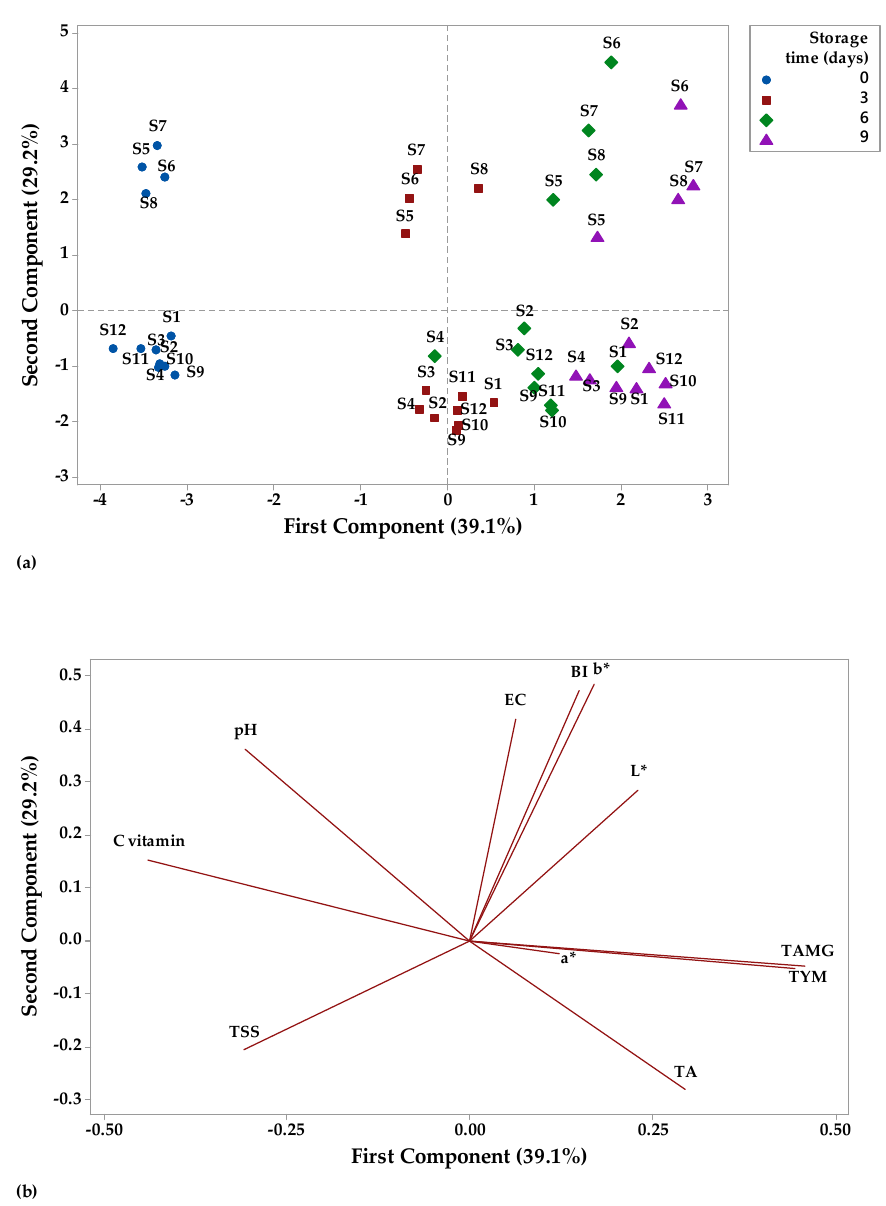
Figure 12. Principal component analysis (PCA) ( a ) scores and ( b ) loading plots of fruit juice samples stored at room temperature.